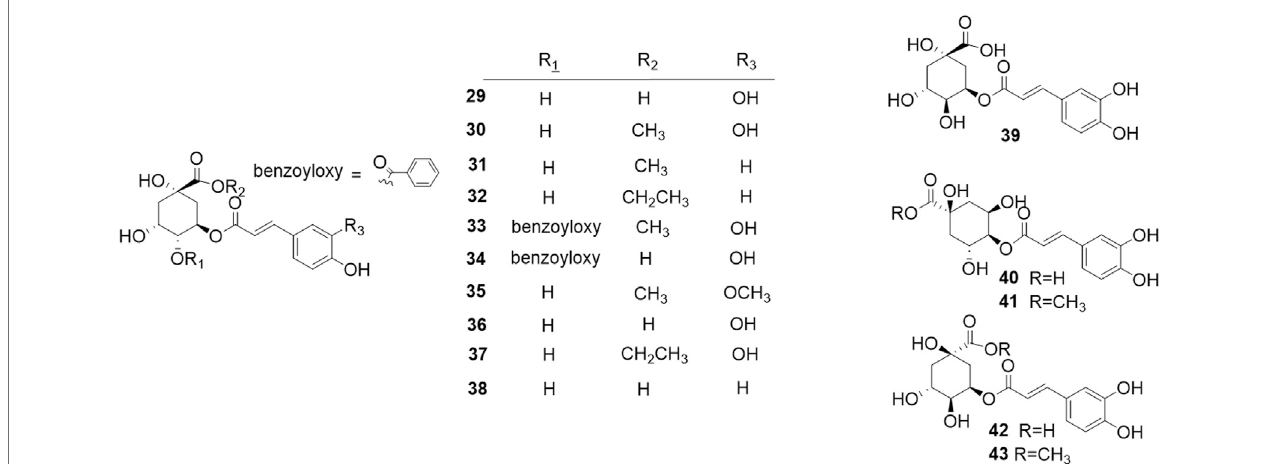
FIGURE 2 | Structures of the hydroxycinnamoylquinic acid derivatives (29 – 43) form P. mume .